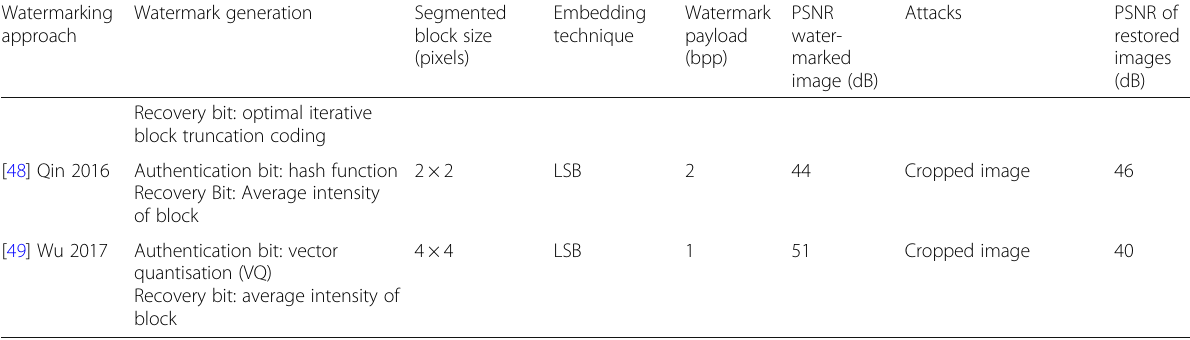
Table 2 Summary of some self-embedding fragile watermarking methods in the spatial domain (Continued) Watermarking